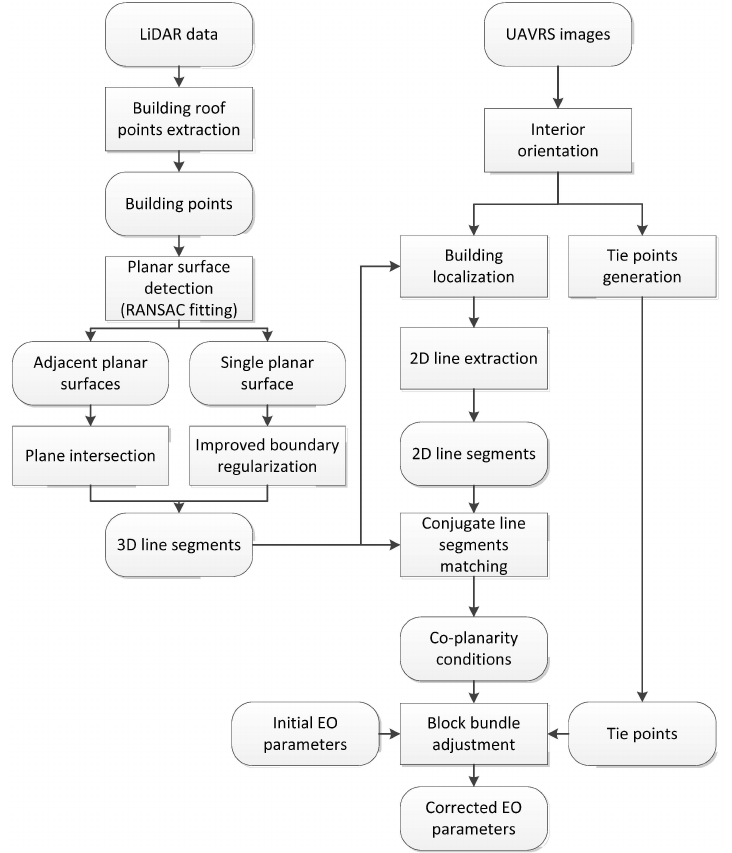
Figure 1. Overall workflow for the registration of UAVRS images and LiDAR